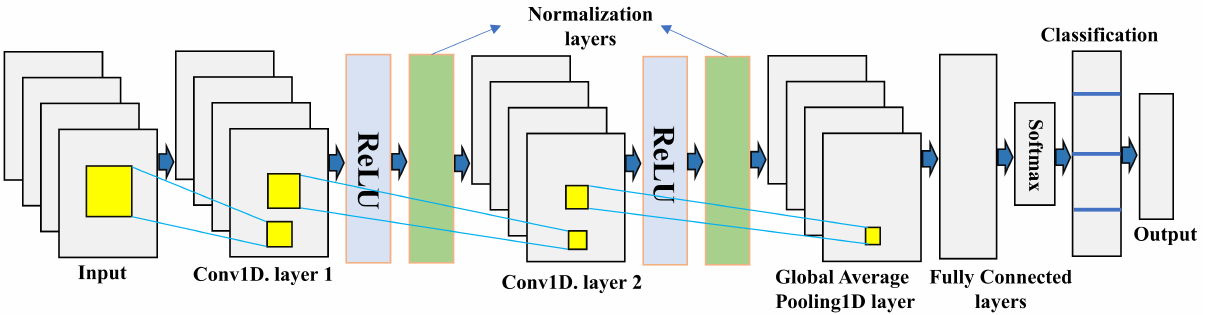
Figure 2. Deep learning architecture using CNN for IRS aided communication